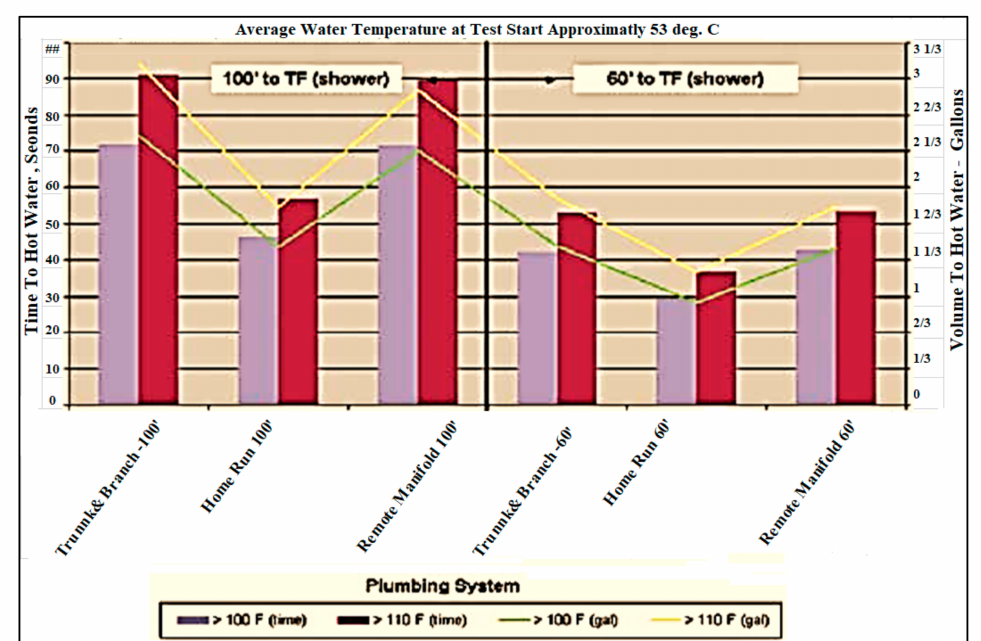
Figure 4. Comparison of Hot Water Delivery